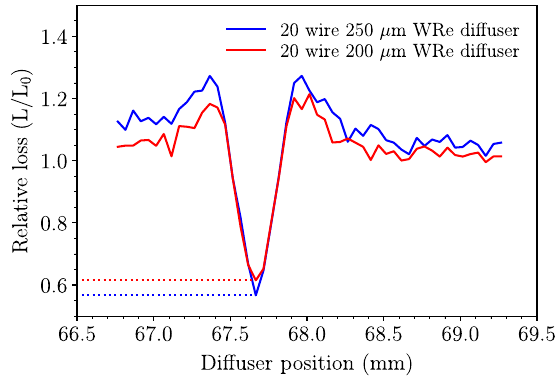
FIG. 10. 2D simulated normalized 400 GeV =c total beam loss vs diffuser position for a 200 - μ m-wide ES, comparing a 250 - μ m- wide WRe diffuser made of ∅ 250 μ m wires and a Ta diffuser made of ∅ 200 μ m wires with half offset by 60 μ m.